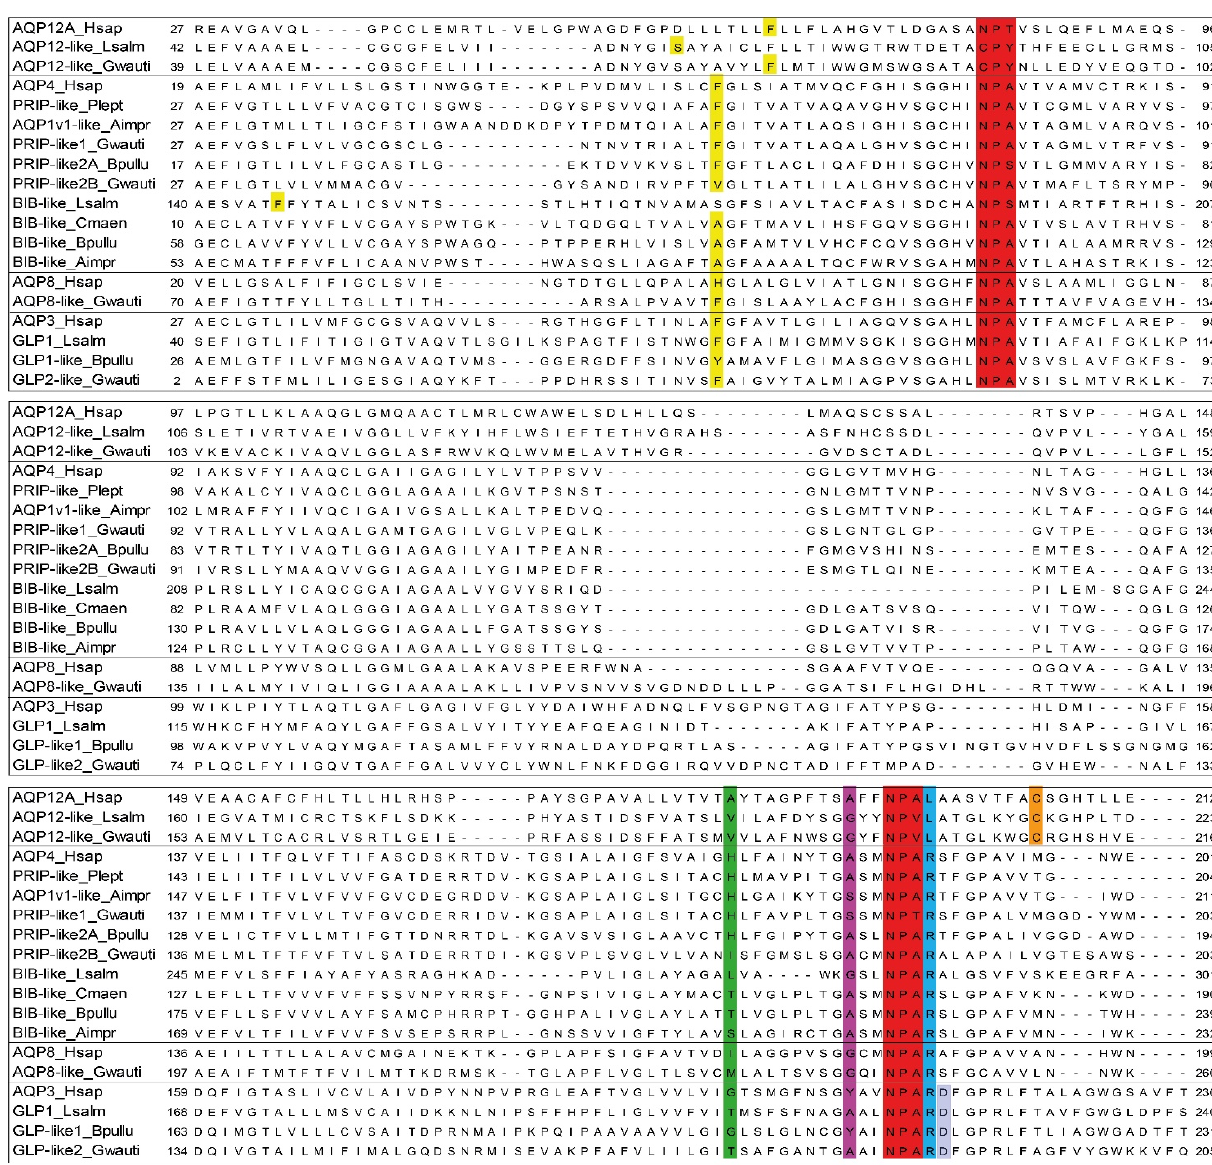
Figure 3. Molecular secondary structures of aquaporins. Multiple alignment of NPA regions of the amphipod (Gwauti: Gammarus wautieri ; Bpullu: Baikalogammarus pullus ) proteins with human (Hsap), copepod (Lsalm), balanid (Aimpr), and decapods (Cmaen: Carcinus maenas ; Plept: Pontastacus leptodactylus ) sequences. In red, the two NPA motifs. The ar/R residues in the different positions have respectively different colors (yellow, green, purple, and light blue respectively). In shaded blue the Asp residue after the second NPA box of the Glp-like. In orange, the Cys residue down in the C-terminus NPA boxes of the Aqp12-like.